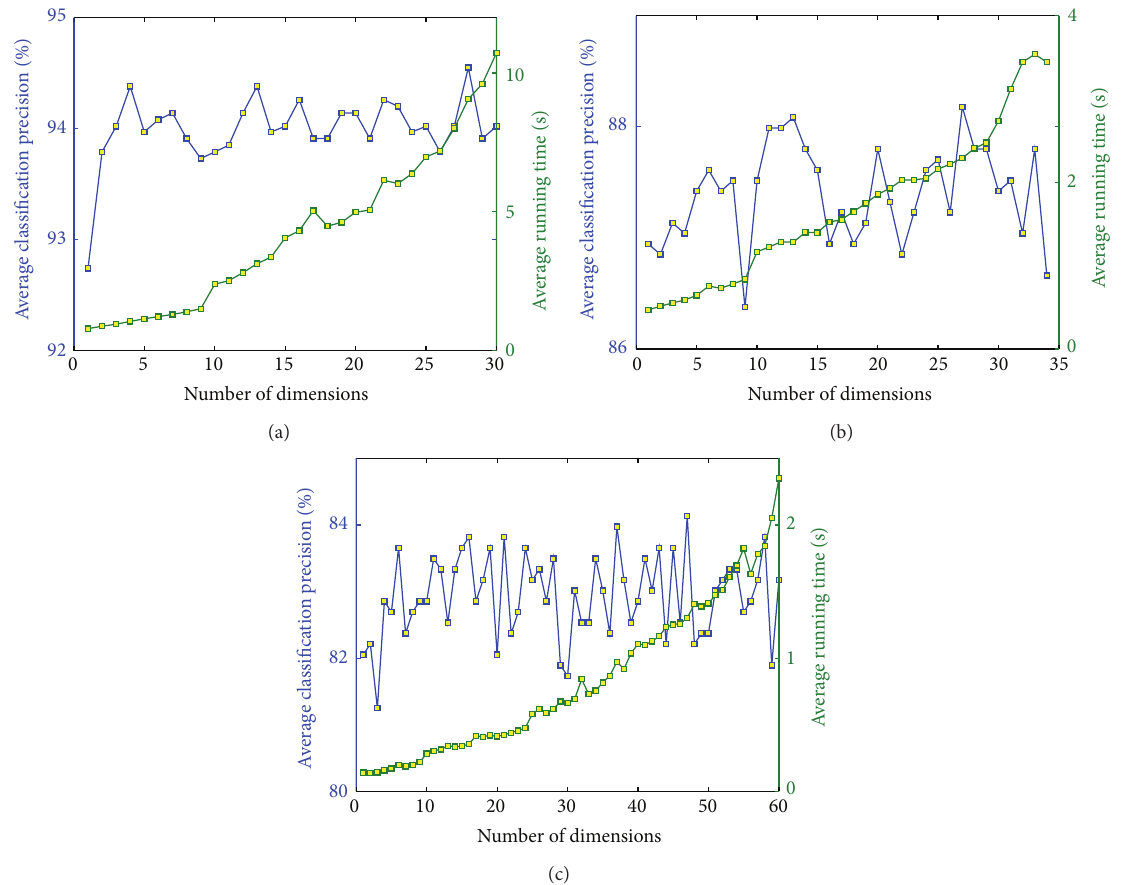
Figure 1: The relationship among the number of dimensions, average classification precisions, and average running times. (a) The experiment results on data set “WDBC;” (b) the experiment results on dataset “Ionosphere;” (c) the experiment results on data set “Sonar.”